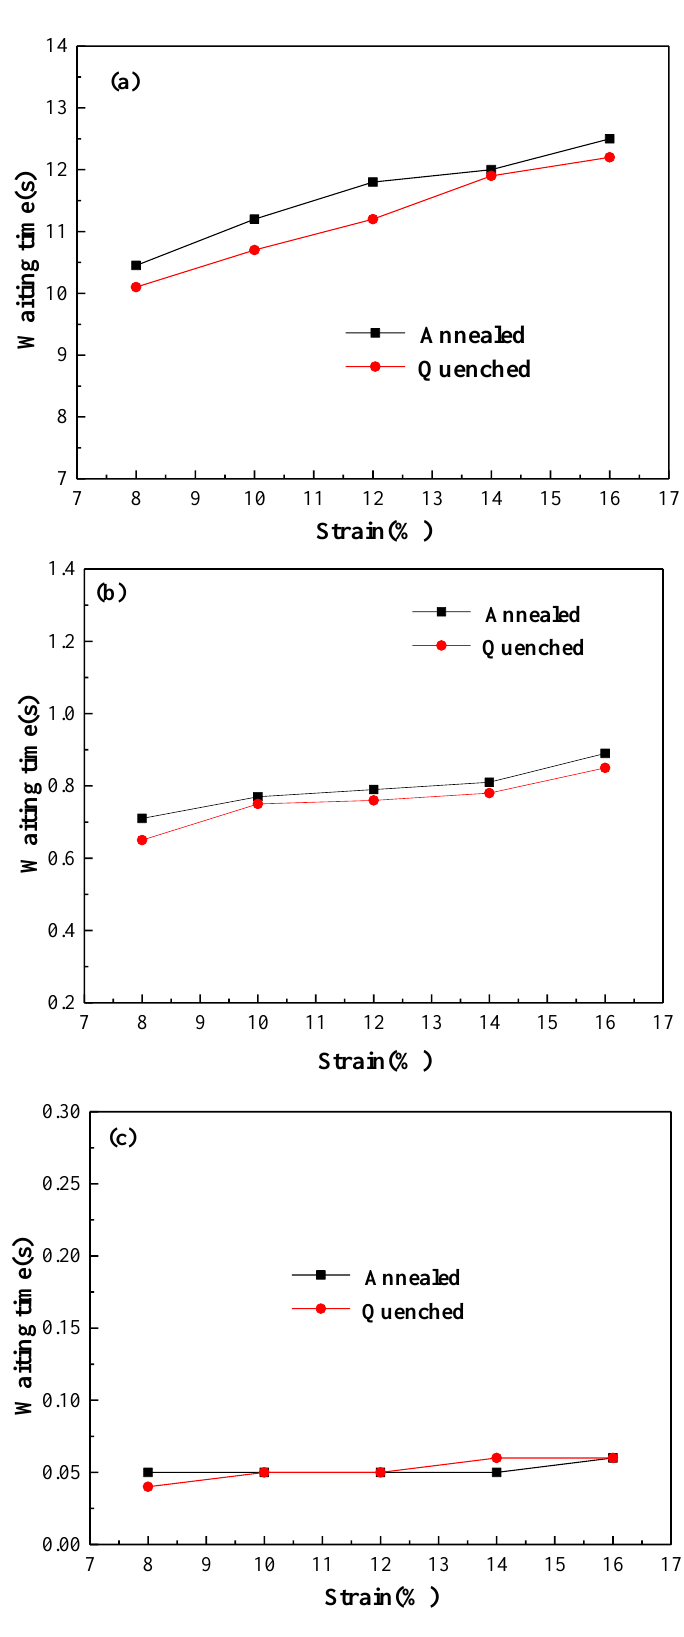
Figure 11. The waiting time (t w ) of the annealed and quenched 5083 Al alloy sheets at different strain rates: ( a ) 1 × 10 −4 s −1 , ( b ) 1 × 10 −3 s −1 , and ( c ) 1 × 10 −2 s −1 rates: ( a ) 1 × 10 − 4 s − 1 ; ( b ) 1 × 10 − 3 s − 1 ; and ( c ) 1 × 10 − 2 s − 1